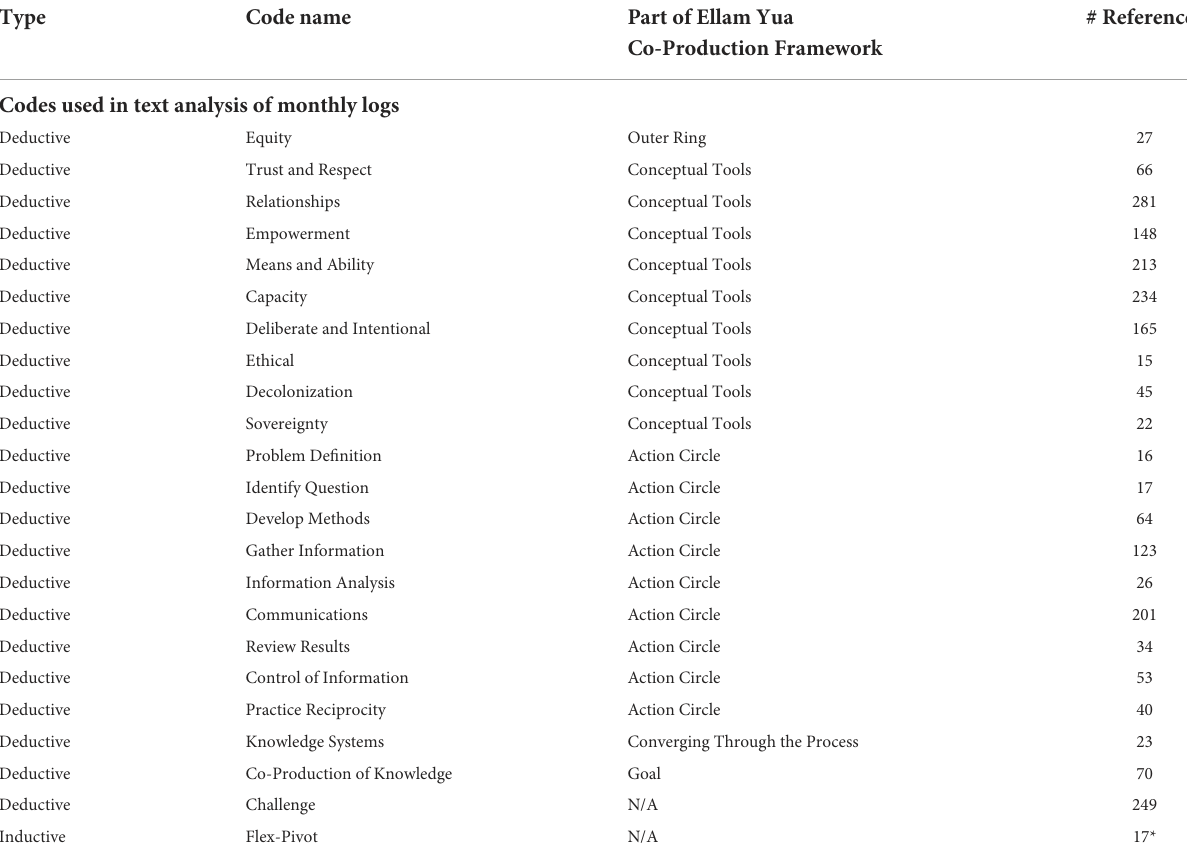
TABLE 6 Type of code (Deductive or Inductive); Code Name (either an element from the Ellam Yua co-production framework or an inductive code); which part of the Ellam Yua co-production framework each code belongs to (see Figure 1; not applicable for the ‘Challenge’ and ‘Flex-Pivot’ codes); and # References (absolute incidence) of each code used in our